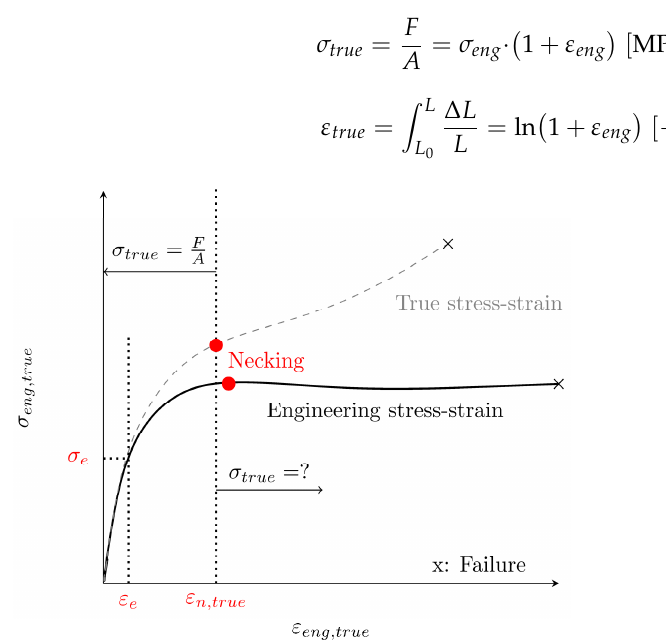
Figure 1. Exemplary engineering stress–strain and true stress–strain curve of a semi-crystalline thermoplastic material. The point of necking is defined as the highest engineering stress followed by a stress decline. ε e marks the end of the elasticity and the true strain ε n , true the beginning of the necking.